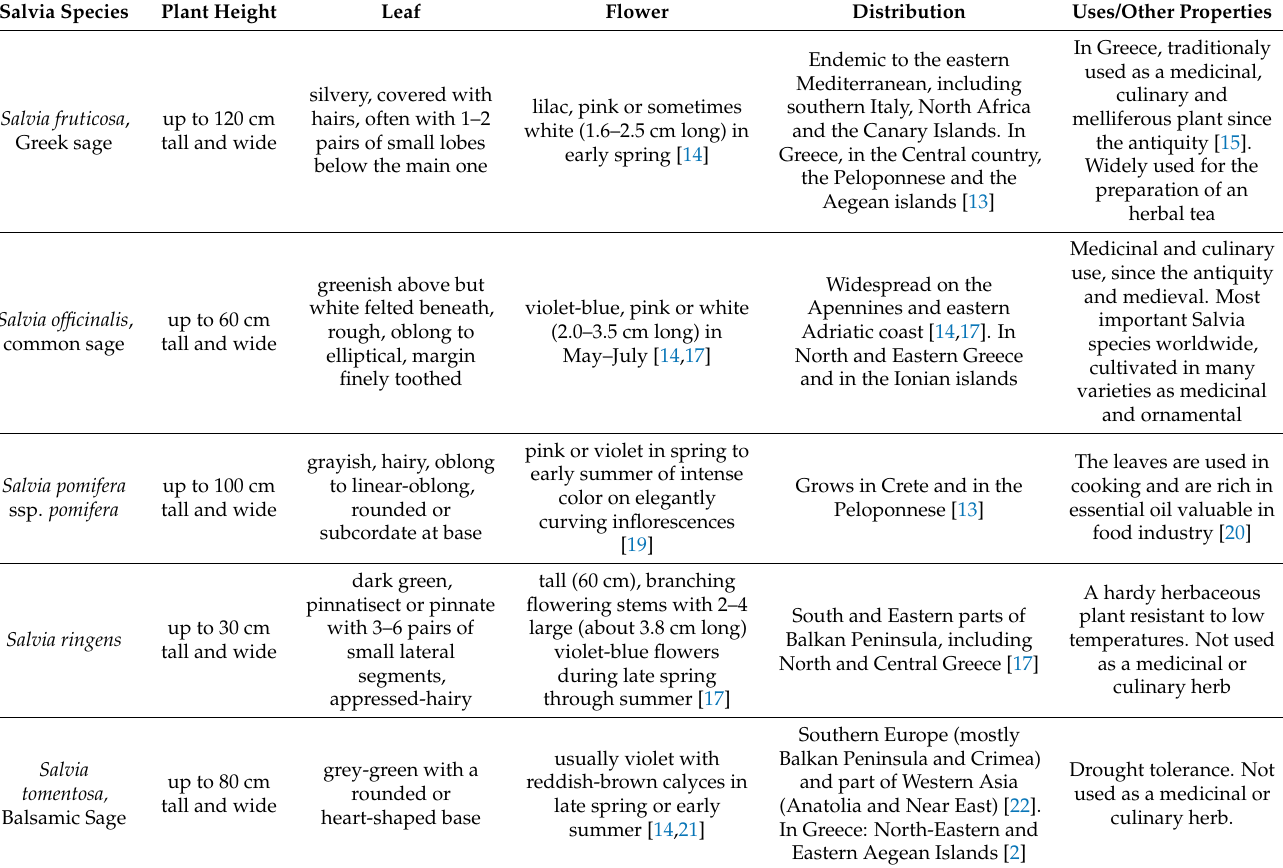
Table 1. Description and properties of the five Greek Salvia species used in interspecific